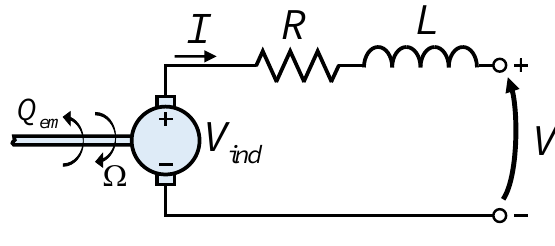
Figure 7. Equivalent electrical circuit of a permanent magnet DC